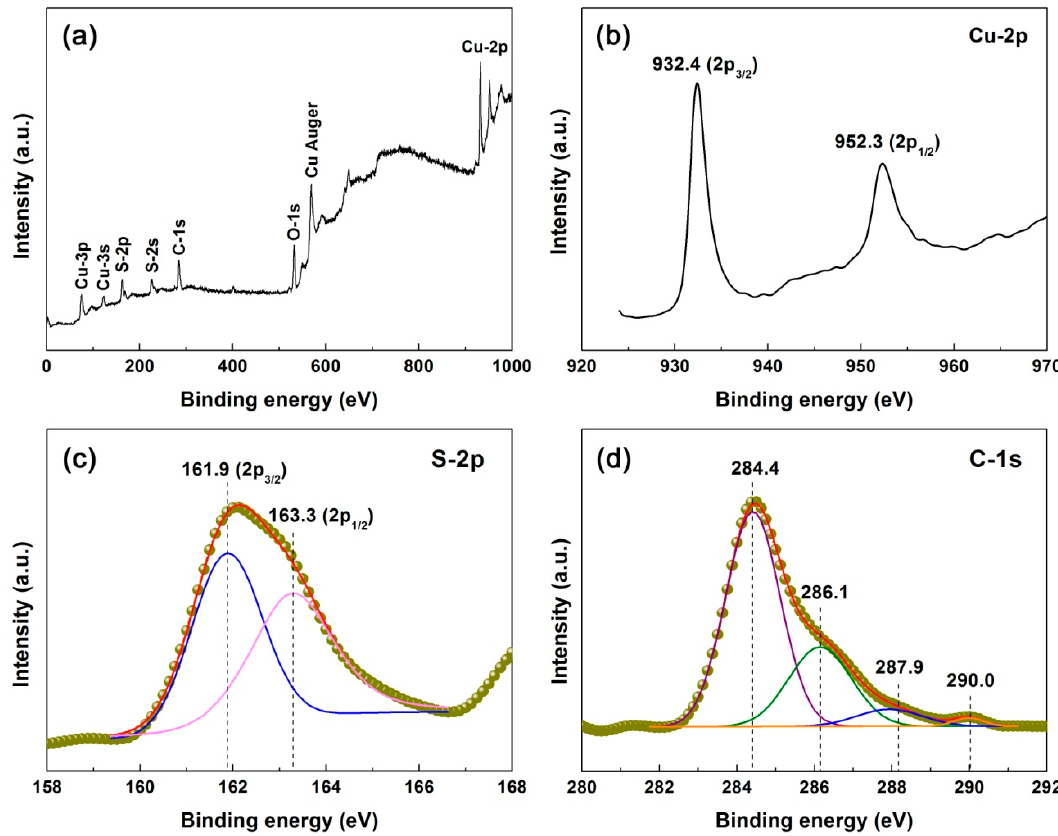
Figure 7. Survey scan XPS spectrum ( a ) and high-resolution XPS spectra of ( b ) Cu-2p, ( c ) S-2p, and ( d ) C-1s of the 3% CNT/CuS composite.